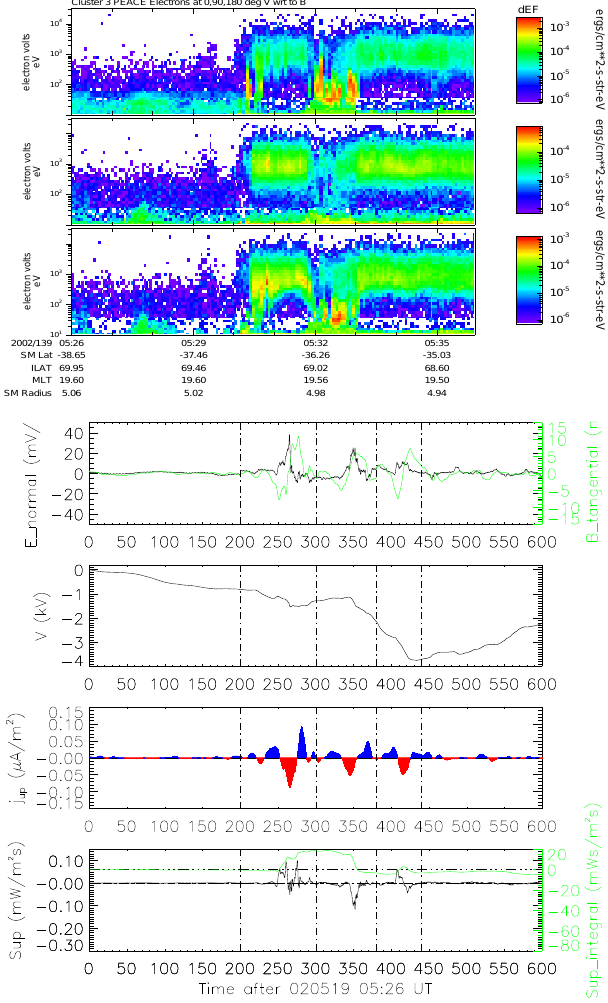
Fig. 5. 19 May 2002, s/c 3. The same panels as in Fig.